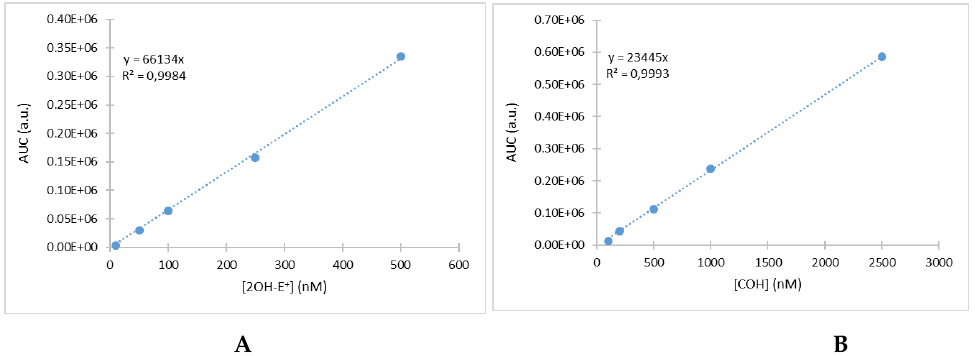
Figure 3. Example of the calibration curve obtained with 2OH-E + ( A ) and COH ( B ).